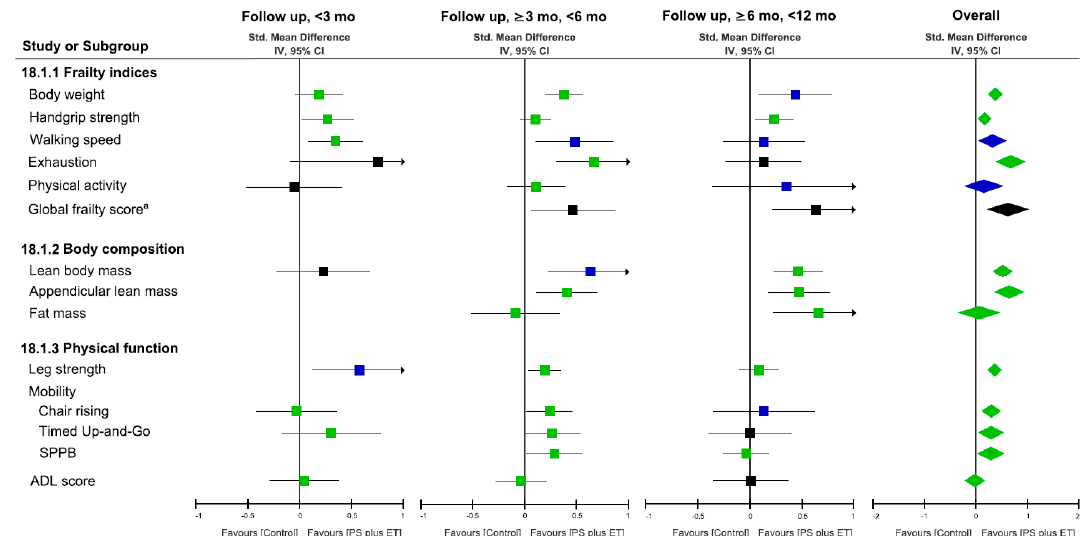
Figure 3. Forest plot of effects of protein supplementation (PS) plus exercise training (ET) on changes in frailty indices, body composition, and physical function at each follow-up duration. Each point estimate at each follow-up duration (square) and during the overall duration (diamond) presents the combined effect (standard mean difference) of the outcome measure where indicated, with 95% CI (horizontal line). Results plotted on the right-hand side indicate effects in favor of PS plus ET. The combined effects analyzed using a fixed- or random-effects model are denoted by green and blue colors, respectively; a black square or diamond denotes that the combined effect is derived from a single study. a Global frailty score is defined as a number out of five frailty components of Fried’s criteria [24]. 95% CI = 95% confidence interval; Std = standard; IV = inverse variance; ADL = activity of daily life; SPPB = short physical performance battery.